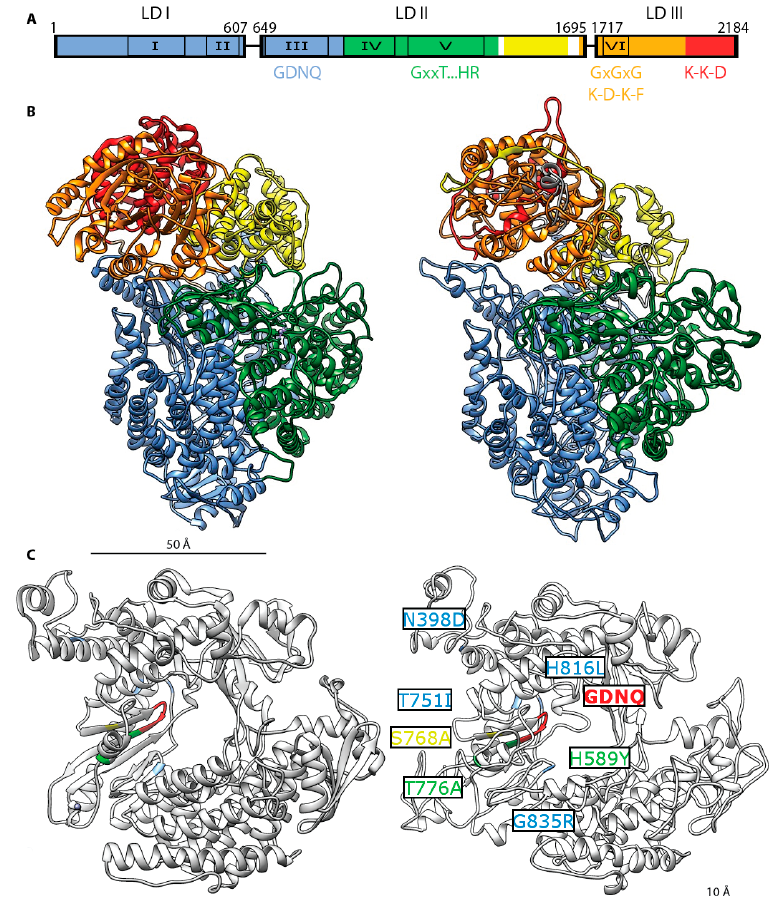
Figure 6. MeV L protein architecture. ( A ) Organization of three conserved domains (LD I–III)